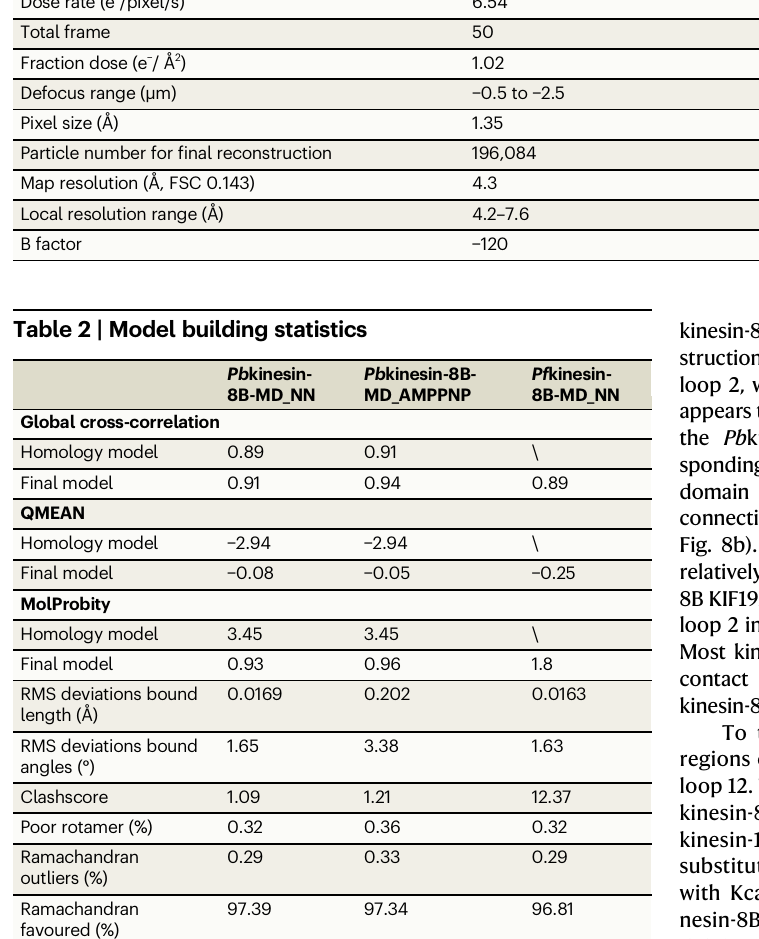
Table 1 | Cryo-EM data collection, 3D image processing statistics Data collection and reconstruction